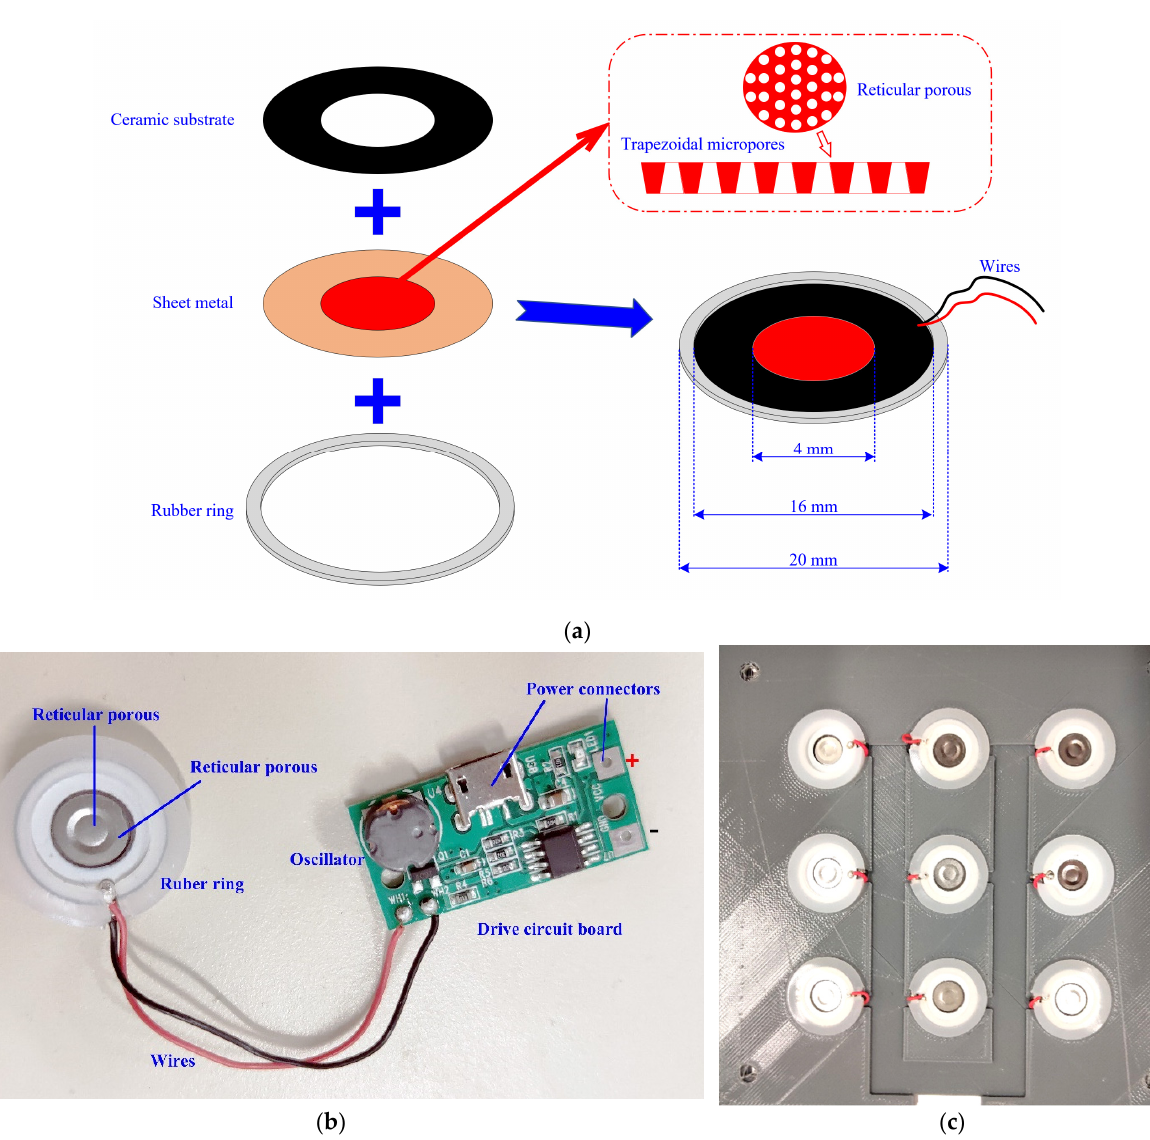
Figure 5. Scheme of the ultrasonic atomizer: ( a ) schematic diagram; ( b ) physical image; ( c ) assembly drawing.